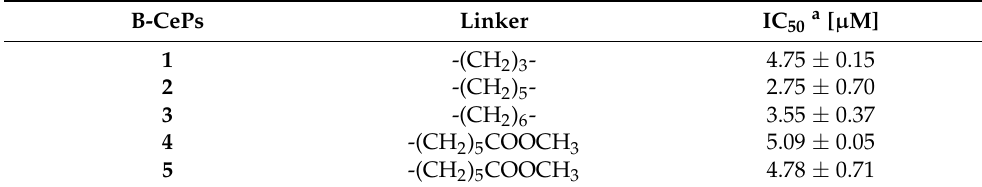
Table 3. Inhibition of NC-mediated melting of individual TAR RNA hairpin by